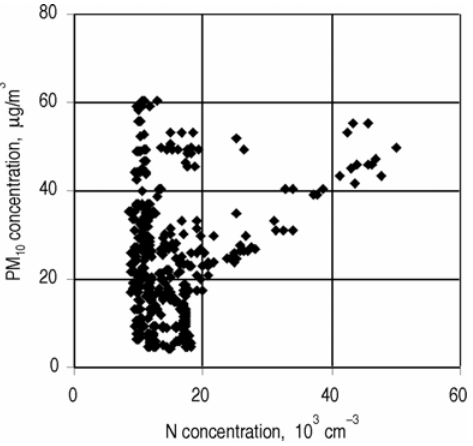
Fig 6 . PM 10 concentration vs aerosol number (N) concent- ration